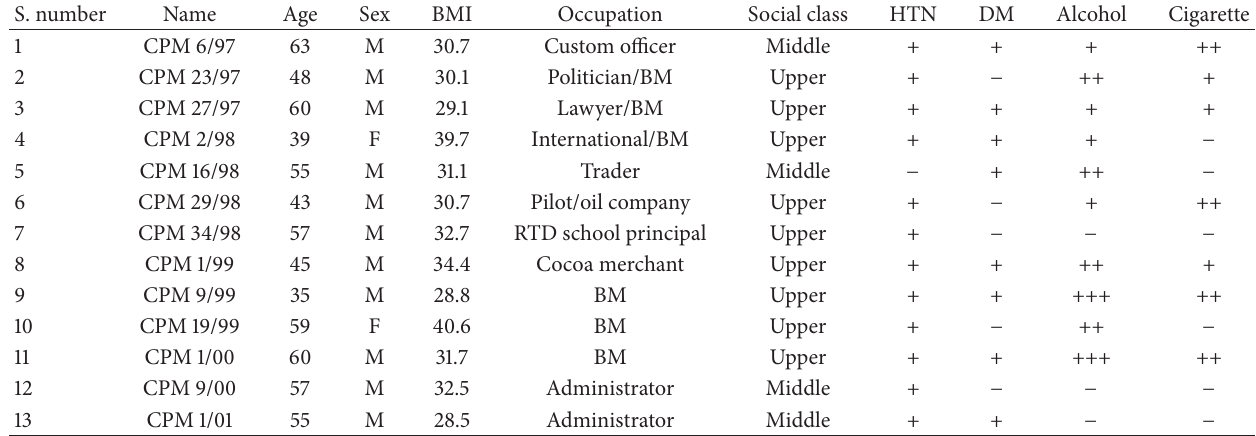
Table 1: The physical, social, and clinical characteristics of the autopsied subjects with MI. S. number